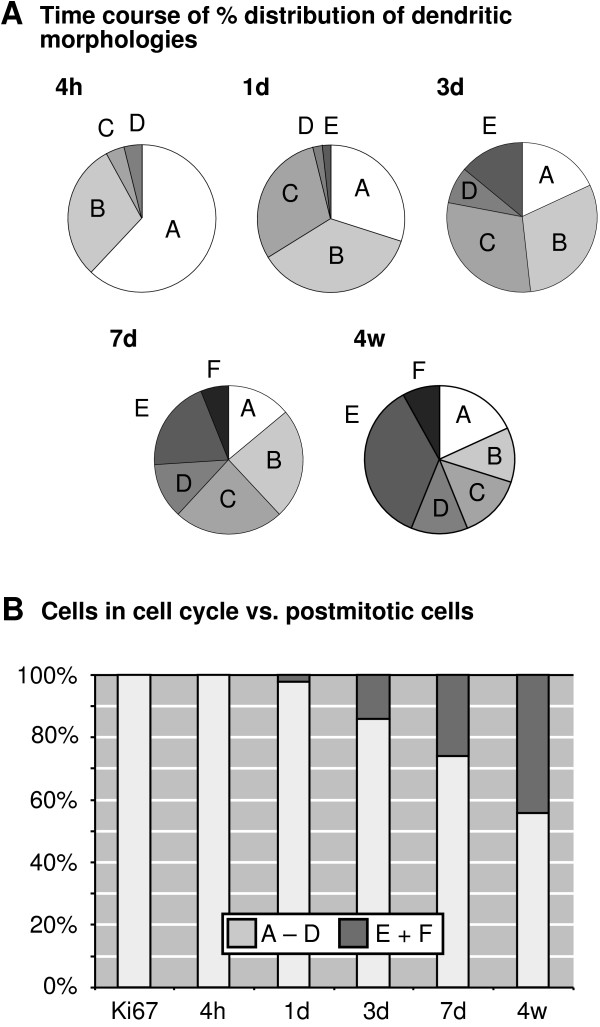
Distribution of dendritic morphologies at different time points after cell division. A, with increasing time after labeling DCX-positive cells with BrdU, the cells progress through the 6 categories of dendritic morphology (cf. Fig. 2). At 4 weeks after BrdU, 45% of the labeled cells have reached the most mature stages E and F. Note that the absolute number of BrdU-positive cells has decreased by this time due to an activity-dependent selection process [2, 8] and that apparently, cells down-regulate DCX soon after reaching category F. Consequently, the relatively large proportion of DCX-positive cells in the potentially proliferative stages A – D (B) corresponds to only a low absolute number at late time points after BrdU.